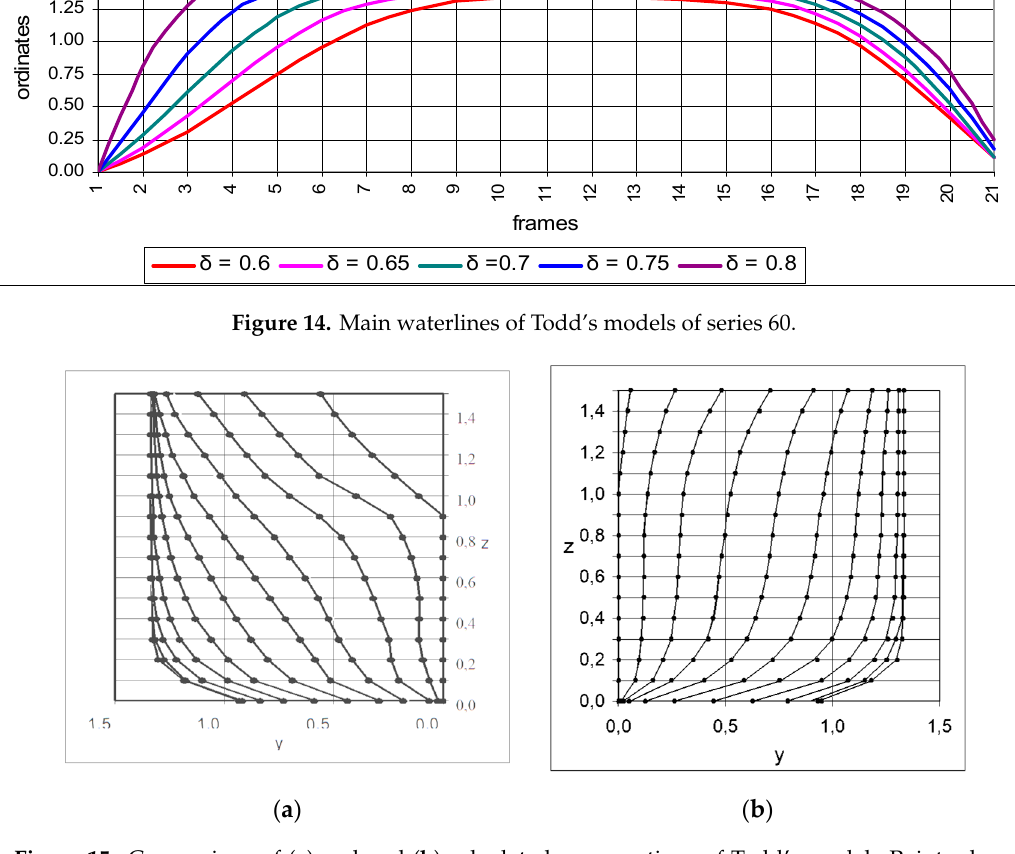
Figure 15. Comparison of ( a ) real and ( b ) calculated cross sections of Todd’s model. Points show calculated values.